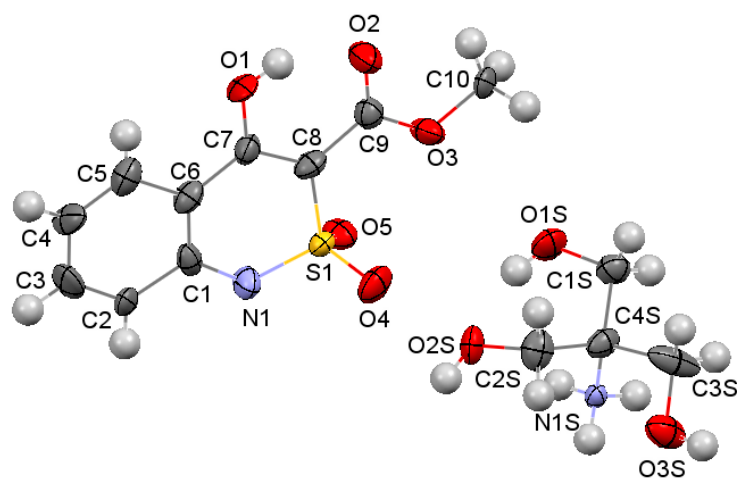
Figure 5. The molecular structure of salt 5a according to X-ray diffraction data. The atoms represented by thermal vibration ellipsoids of 50% probability.